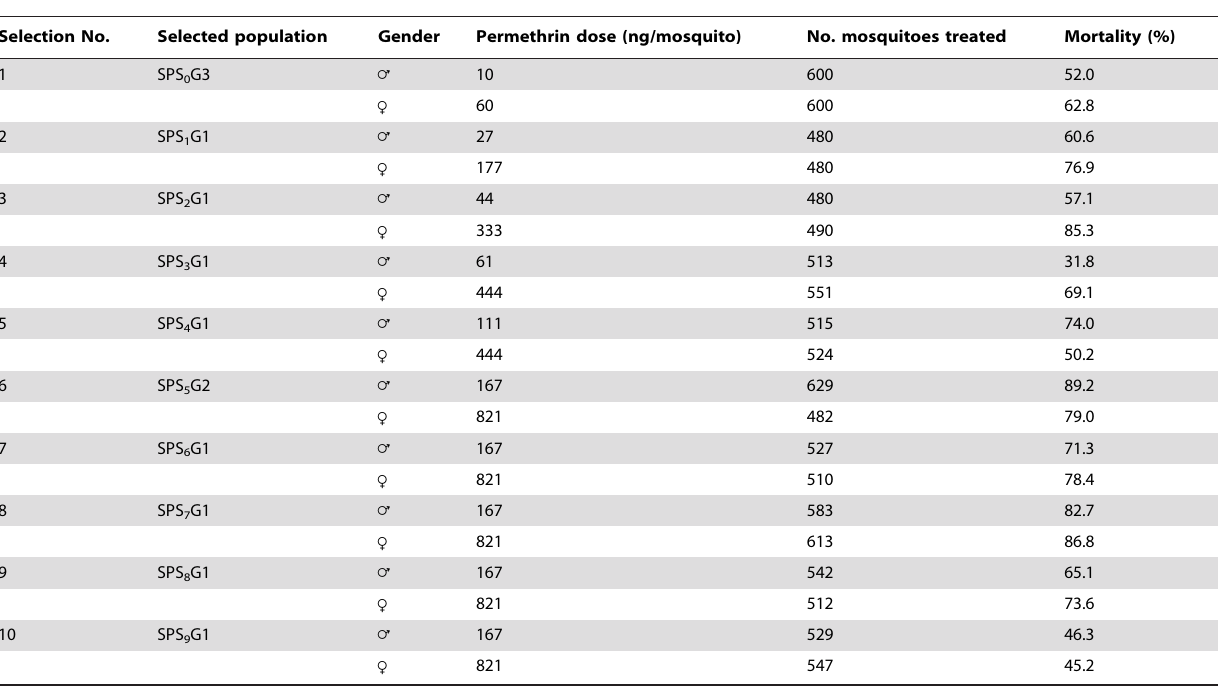
Table 1. Selection of the SP strain of Aedes aegypti in the laboratory by permethrin.